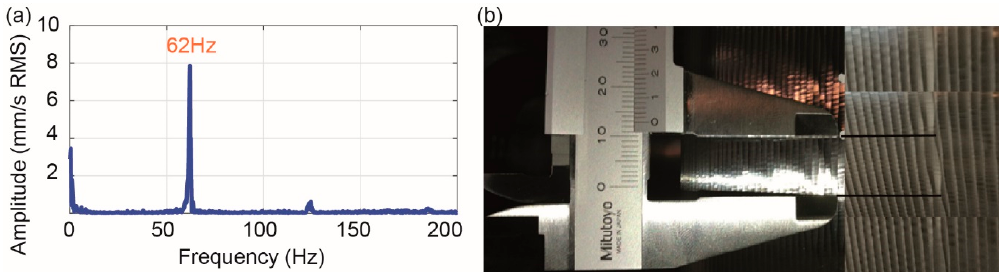
Figure 3. Machining of 36” wheelset (Vc = 66 m/min; a p = 15 mm): ( a ) Vibration spectrum from the left turret accelerometer ( X axis). ( b ) Corresponding chatter marks.